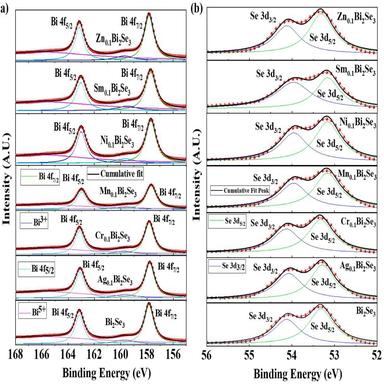
(a) XPS spectra of all the intercalated and pure Bi2Se3 showing the Bi 4f core level spectra. (b) XPS spectra of all the intercalated and pure Bi2Se3 showing the Se 3d core level spectra.